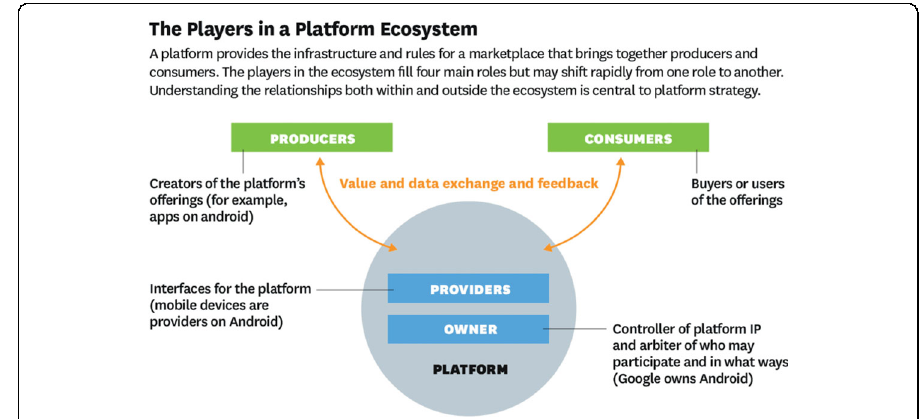
Fig. 2 The Players in a Platform